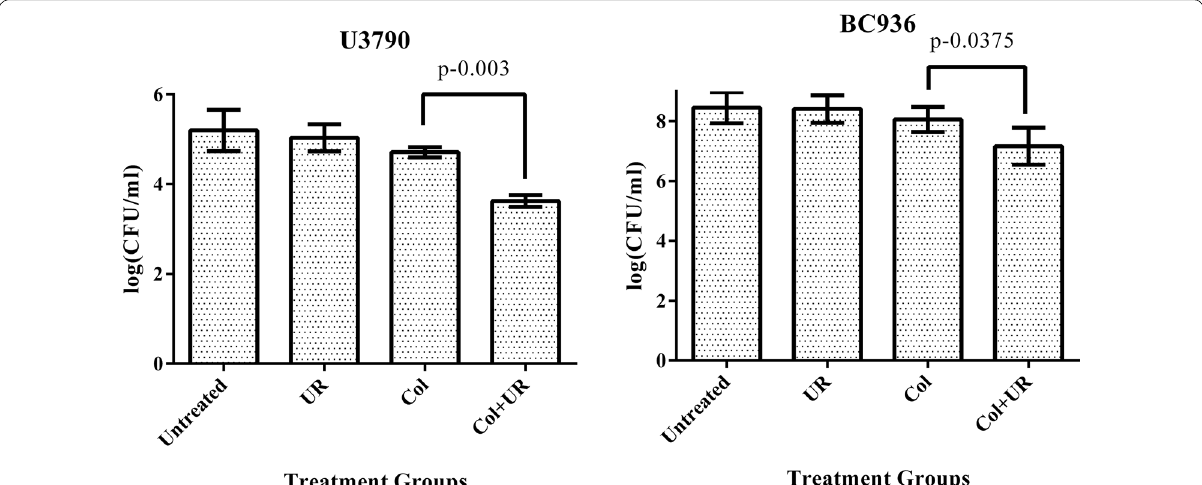
Fig. 3 Ursolic acid synergistically potentiates bactericidal effect of colistin in infected zebrafish. E. coli U3790 and K. pneumoniae BC936 were intramuscularly injected in zebrafish and treated with either colistin (Col)/ursolic acid (UR) or colistin Following treatment, fish were euthanized and the muscle tissue was collected in PBS, homogenized, serially diluted and plated onto LB agar. The colony counts was scored after 24 h and represented as log CFU/ml. The error bar represents the standard error of mean of three independent